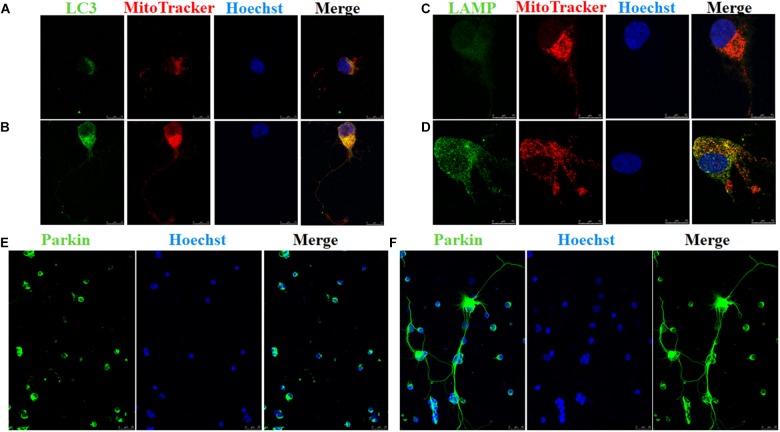
Immunofluorescence of RGCs after overexpression of OPA1 under glutamate excitotoxicity. RGCs co-stained with MitoTracker Red and LC3 or LAMP1 (A–D). Glutamate treatment induced small spherical mitochondria and low immunoreactivity of LC3 and LAMP1 (A,C). Overexpression of OPA1 induced more number of large mitochondria, reduced glutamate-induced mitochondrial fragmentation (B,D), upregulated the immunoreactivity of LC3 (B) and LAMP1 (D), and the co-localization between mitochondria and LC3 in the axons of the RGCs (B). It also accumulated co-localization between LAMP1 and mitochondria in the RGCs under glutamate excitotoxicity (D). Immunofluorescence shows parkin expression in RGCs transfected with Ad null and Ad-OPA1 (E,F). Compared with the Ad null transfected RGCs (E), immunoreactivity of parkin were upregulated in the axons of the RGCs transfected with Ad-OPA1 (F). Scale bar = 10 μm (A–D). Scale bar = 25 μm (E,F).